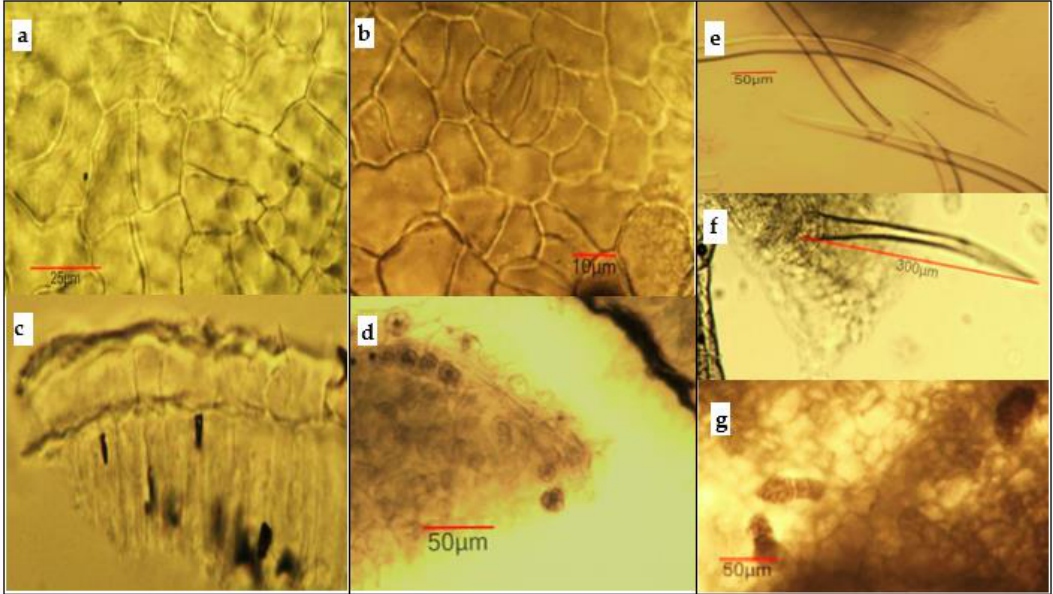
Figure 3. Microphotos of powdered leaf samples of Koelreuteria paniculata: ( a ) upper leaf epidermis in surface view; ( b ) lower leaf epidermis in surface view, with anomocytic stomata; ( c ) fragments of leaf lamina in transverse section with upper epidermis and palisade parenchyma; ( d ) oxalate druses around the vascular bundle; ( e ) isolated covering trichomes; ( f ) unicellular-covering trichome with part of the epidermis; ( g ) glandular trichomes of lower leaf epidermis.